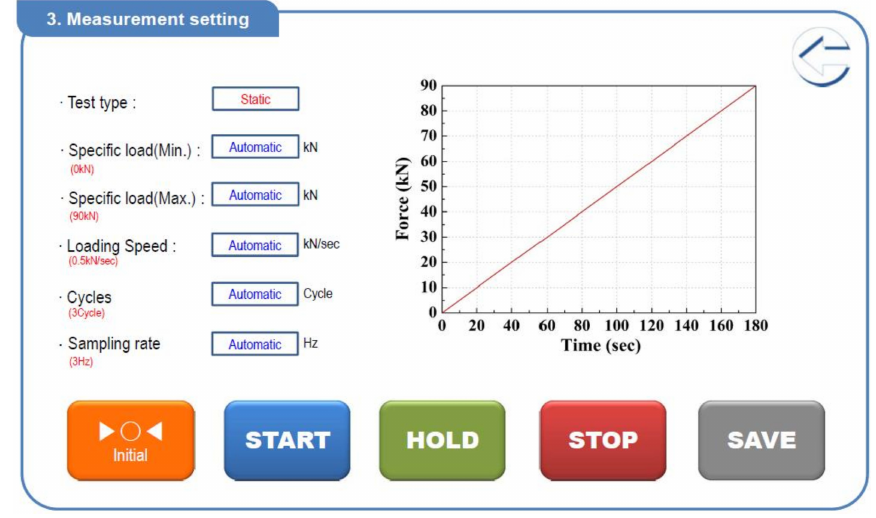
Figure 8. Schematics of test and evaluation program for measurement system (S / W).